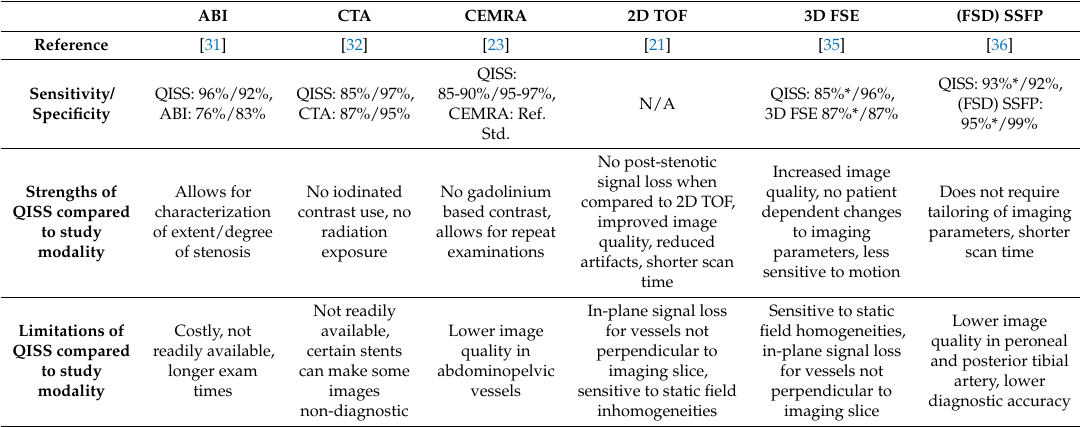
Table 2. Summary of studies comparing the diagnostic accuracy, strengths and limitations of QISS to other PAD diagnostic modalities for clinically significant